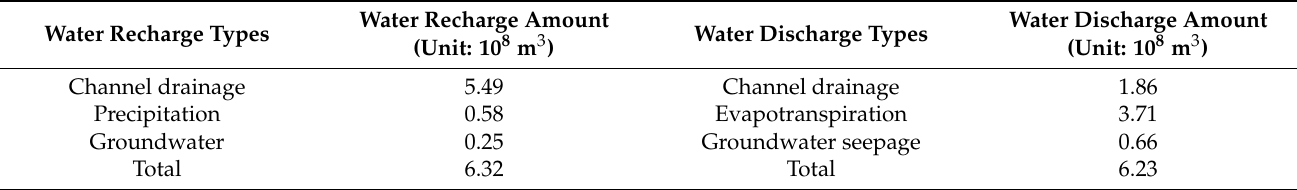
Table 1. Water balance analysis for Wuliangsu